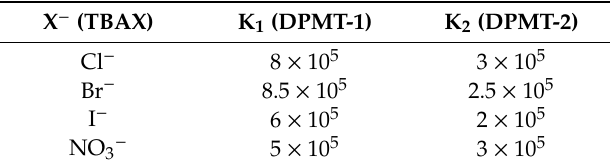
Table 2. Corrected association constants for binding of various anions to DPMT-1 and DPMT-2 in CDCl 3